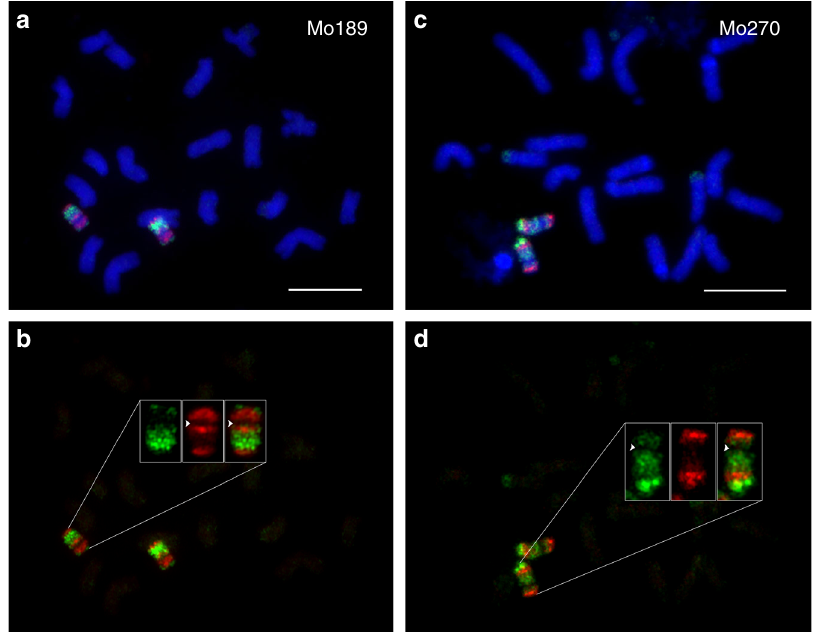
Fig. 7 Oligo-FISH characterization of two lines from the IBMRIL population. a Oligo-FISH analysis of Mo189. Bar = 10 μ m. b The oligo-FISH signals of the two chromosome 10 were digitally separated from panel ( a ). Signals from one copy of chromosome 10 are exempli fi ed. Two B73 chromosomal blocks (red), including the centromere, and two Mo17 blocks (green) are identi fi ed on chromosome 10. Arrowheads indicate the centromeric region that shows weak signals due to few oligos available. c Oligo-FISH mapping of Mo270. Bar = 10 μ m. d The oligo-FISH signals of the two chromosome 10 were digitally separated from panel ( c ). Signals from one copy of chromosome 10 are exempli fi ed. Two Mo17 blocks (green), including the centromere and two B73 blocks (red) are identi fi ed on chromosome 10. Arrowheads indicate the centromeric region that shows weak signals due to few oligos available. The original gray-scale images used to generate the color images in Fig. 7a and c are provided as a Source Data fi